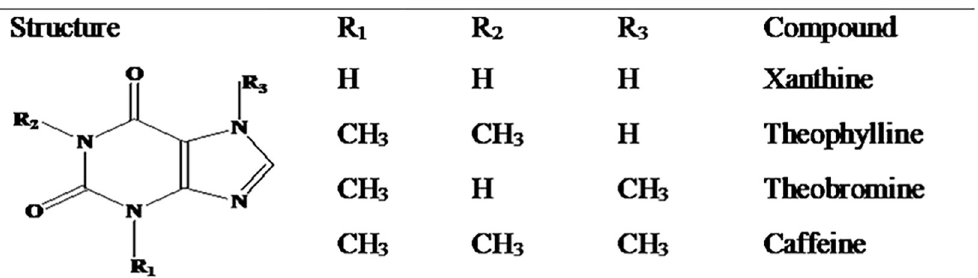
Fig 1. Structure of xanthine and its naturally occurring N-methyl